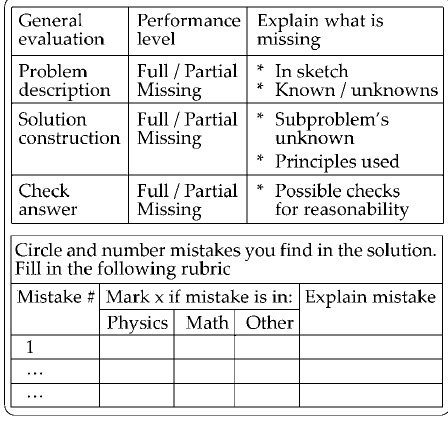
FIG. 3. Self-diagnosis rubric.